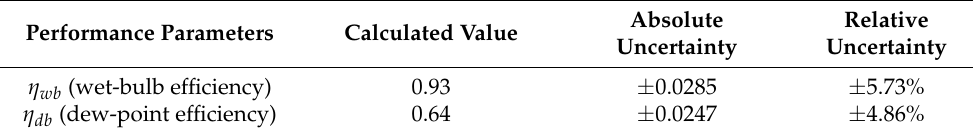
Table 5. Results of uncertainty analysis (T 1 = 40.36 ◦ C, T 3 = 27.8 °C, v = 2 m/s). Performance Parameters Calculated